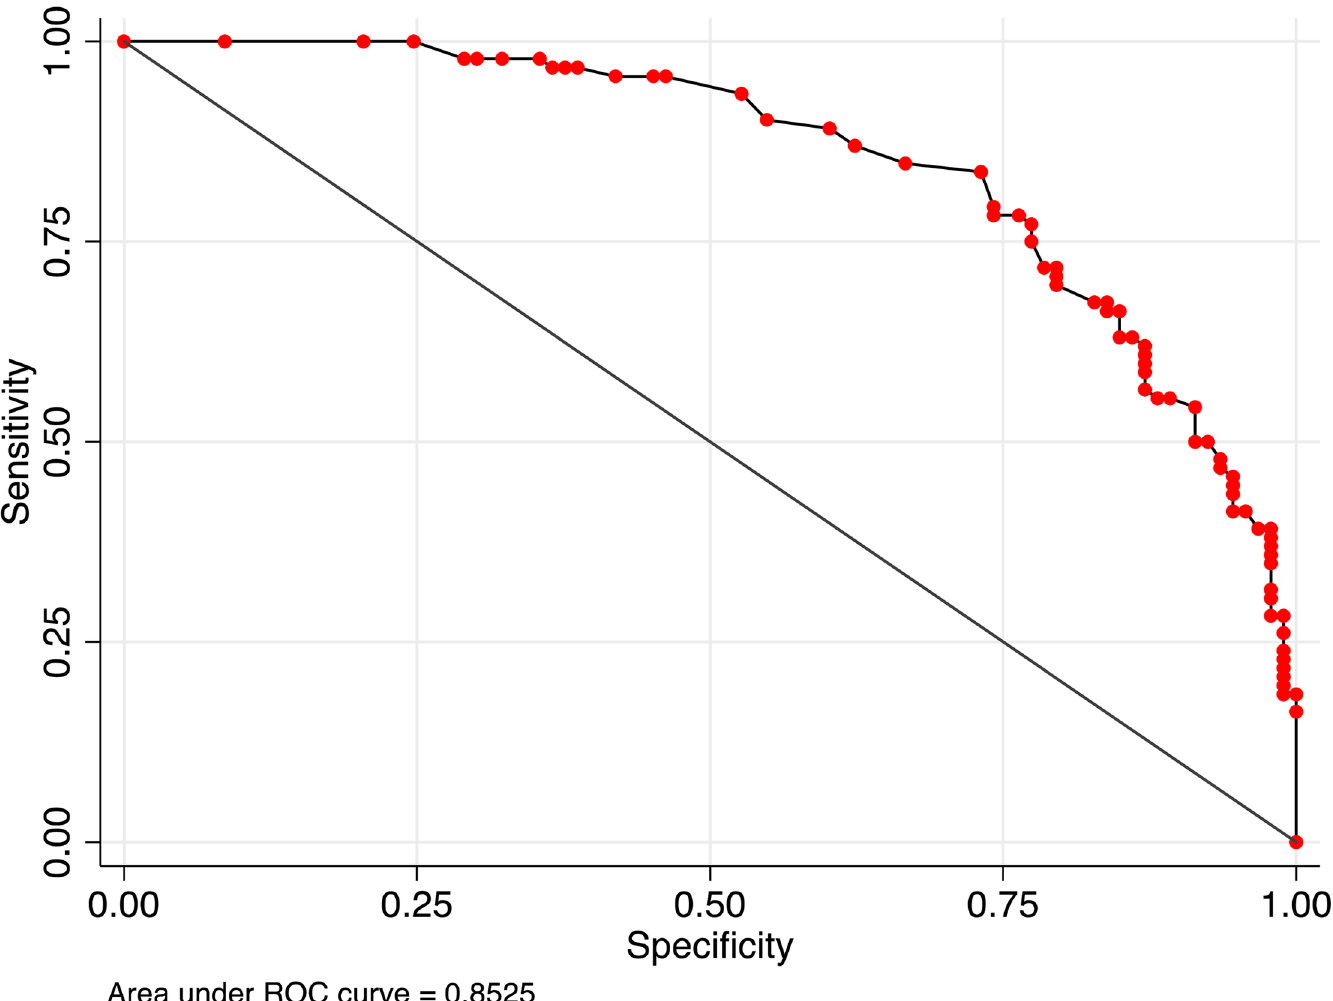
Fig 3. Receiver operating characteristics